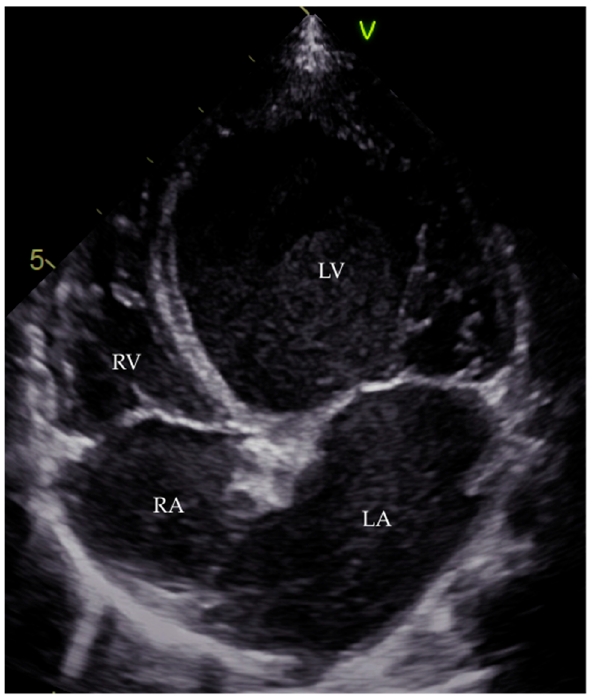
Figure 4. Four-chamber apical view echocardiogram of an 11-month-old boy with DCM. RA, right atrium; LA, left atrium; RV, right ventricle; LV, left ventricle.